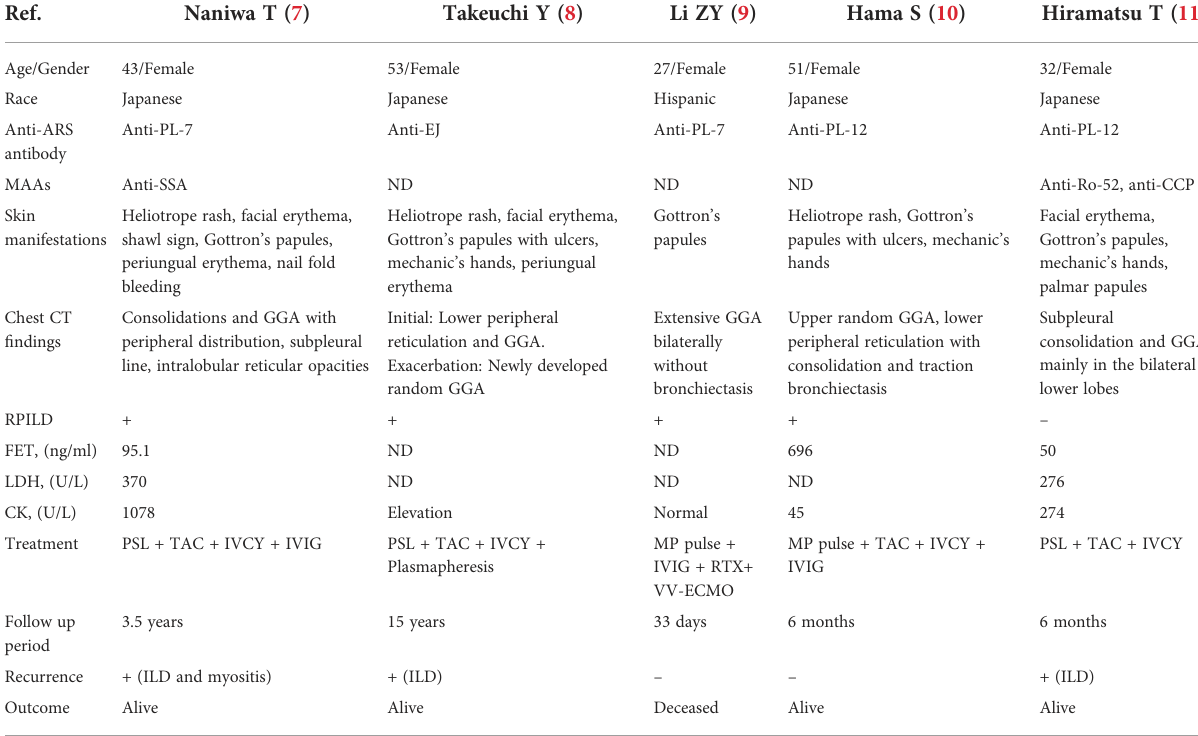
TABLE 3 Characteristics of the fi ve published anti-MDA5+/ARS+ dermatomyositis cases.